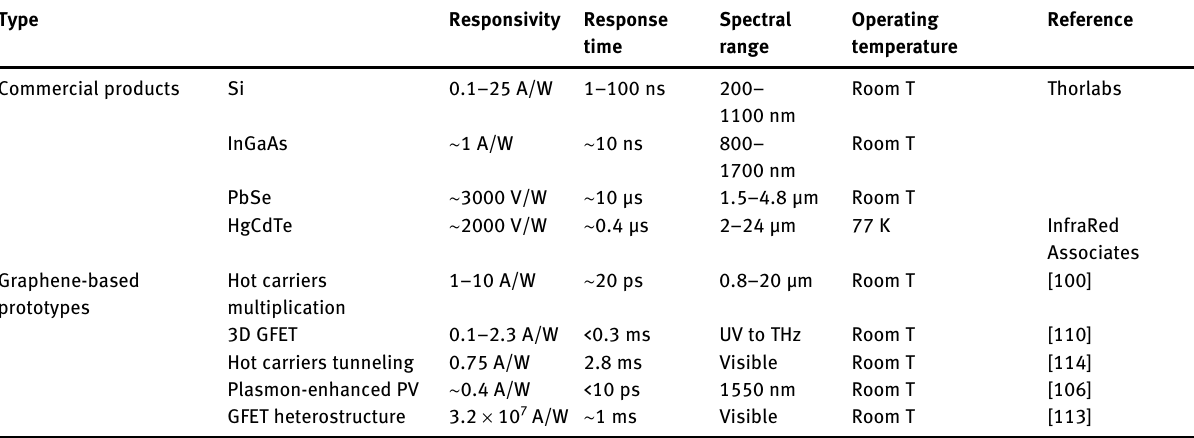
Table  : Performance comparison of commercial photodetectors and graphene-based prototypes. Type